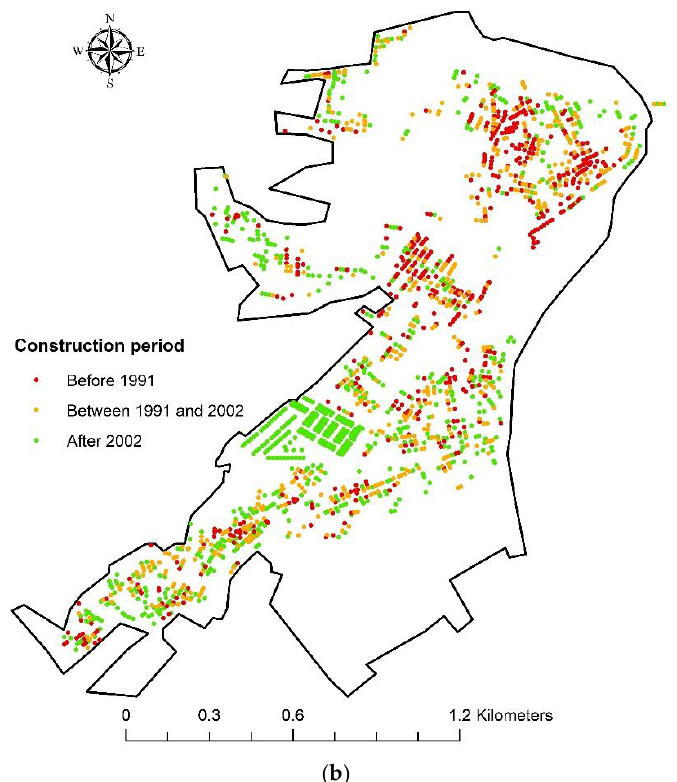
Figure 10. Inspected buildings in the city of Imzouren based on ( a ) seismic code and ( b ) construction period.